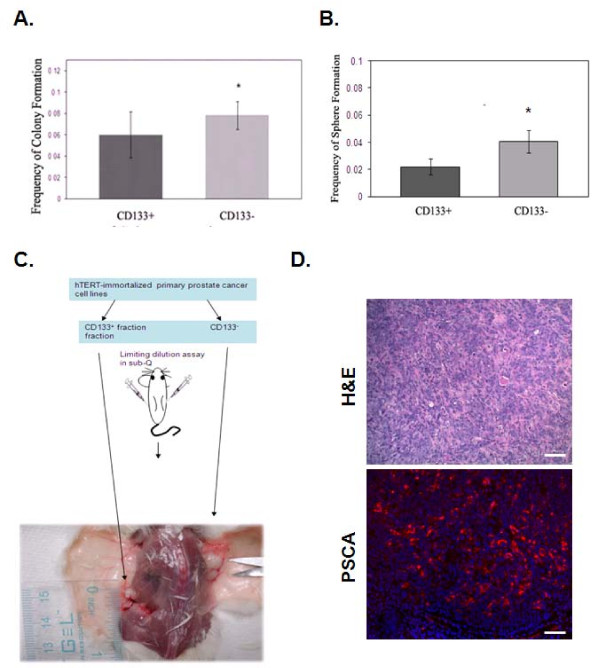
Lack of enhanced tumorigenicity of CD133+ enriched cells. A). Double FACS sorted CD133+ subpopulations were assayed for colony-forming advantage relative to the CD133- subpopulation. A) 2D colony-forming assay or B) sphere-forming assay. Data are expressed as means ± standard deviations. Statistical comparisons are with the CD133+ subpopulation, *P = 0.1; **P < 0.05. C). Schematic depiction of assay in mice with CD133-fractioned RC-58T/hTERT/SA#4-D cells as a representative of all tested hTERT-immortalized primary prostate cancer cell lines. In NOD-SCID mice, CD133- cells generated larger tumors than CD133+ cells. D). Formalin-fixed, paraffin-embedded tissues were obtained from xenograft tumors. Individual tissues sections were stained with H&E or human specific primary PSCA antibody, and Alexa Fluor-594 secondary (red) and Dapi (blue) nuclear stain. Scale bar indicates 40 μM.